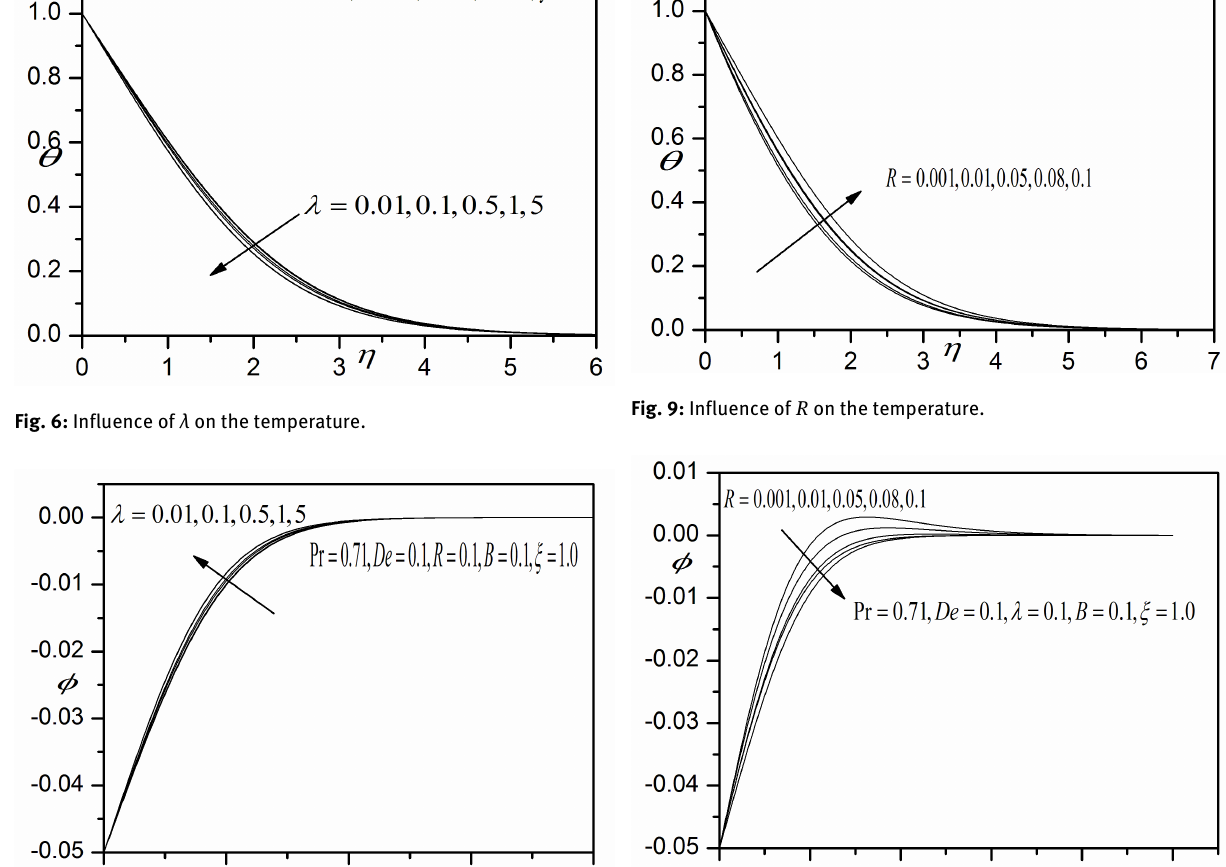
Fig. 10: Influence of R on the angular